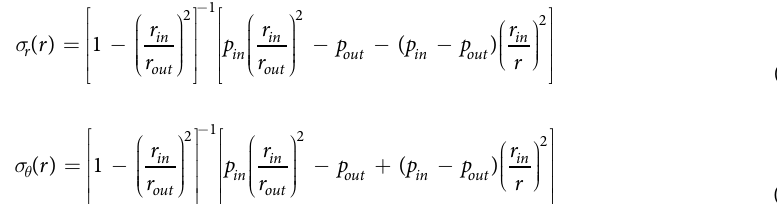
Figure 2b shows the radial and hoop stress behaviours along the tube wall (between r in = 40 μ m and r out = 80 μ m) for the situation in which the tube wall is subjected to an external pressure of 50 bar and an internal pressure of 1 bar (according to Equations 3 and 4). Note that the absolute value of the radial stress at the outer radius assumes the external pressure value ( p out = 50 bar = 5 MPa), whereas that at the inner radius assumes the internal pressure value ( p in = 1 bar = 0.1 MPa), which are the boundary conditions of the problem. Furthermore, numerical data attained from a finite-element-based model built using the COMSOL ® software are also shown in Fig. 2b (green triangles and dark red circles). It is seen that the analytical and numerical results are very similar. Stresses written in polar coordinates ( σ r and σ θ ) can be readily expressed in rectangular coordinates ( σ x and 11 . To attain σ σ σ y ) by employing the transformations presented in Equation 5 x and y along the horizontal axis, one sets θ = 0 and, therefore, concludes that σ r = σ x and σ θ = σ y . σ By identifying that along the horizontal axis, σ x can be expressed by Equation 3 and σ y by Equation 4, and by substituting these results into Equation 1, one can obtain Equation 6, which expresses the behaviour of the material birefringence at a position x along the horizontal axis inside the capillary wall. Moreover, for obtain- ing Equation 6, as shown below, it is assumed that n x 0 and n y 0 are identical (no birefringence under no stress). Additionally, one defines gauge pressure as p gauge ≡ p out − p in .